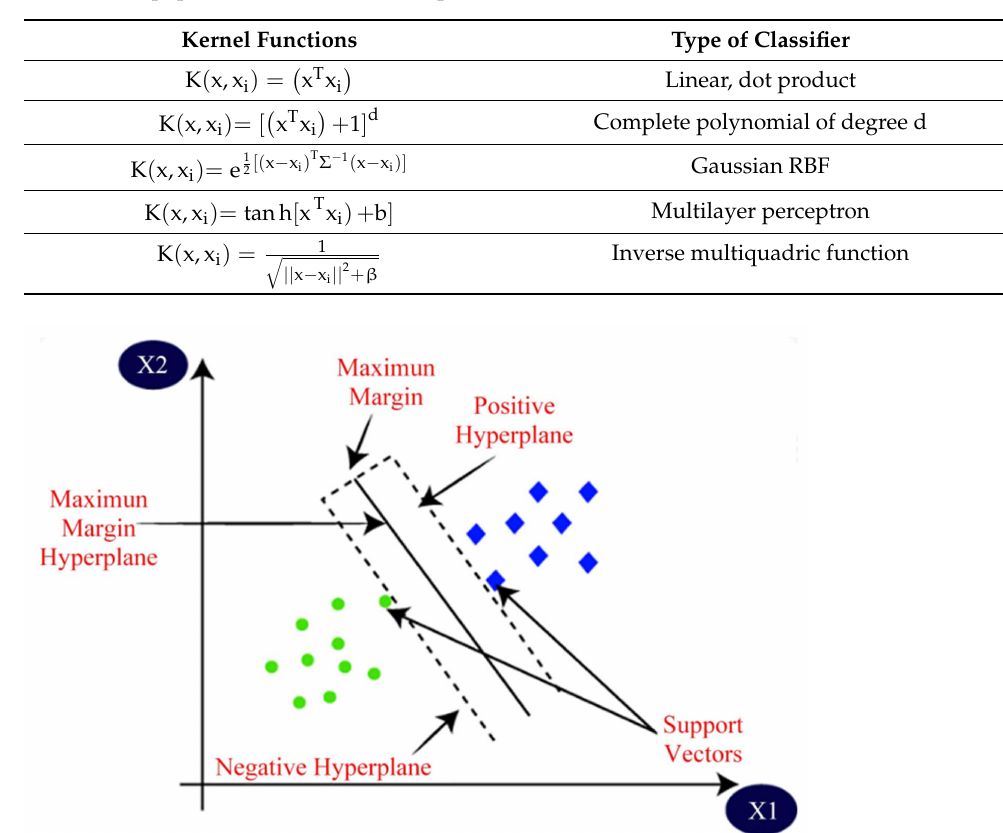
Table 1. The popular admissible Kernel equations [25].